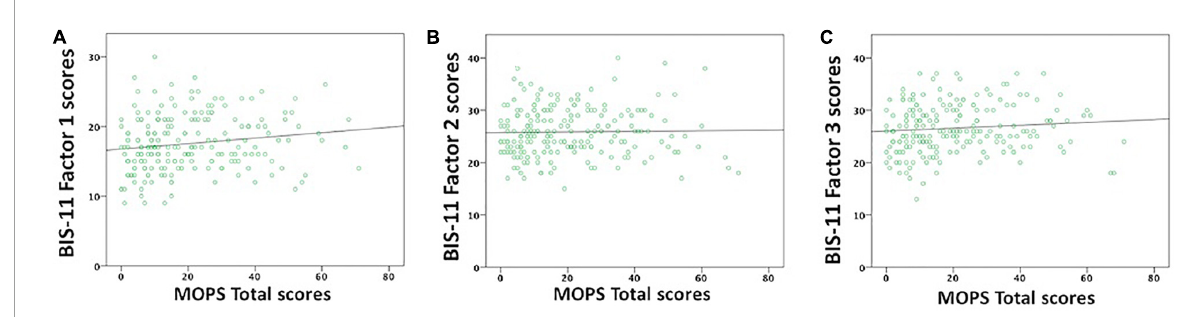
FIGURE1 Correlations between BIS-11 subscales and MOPS Total scores. MOPS Total scores significantly correlated with BIS-11 (A) cognitive/attentive (Factor 1) scores, but not with (B) motor (Factor 2) and (C) non-planning (Factor 3) scores.